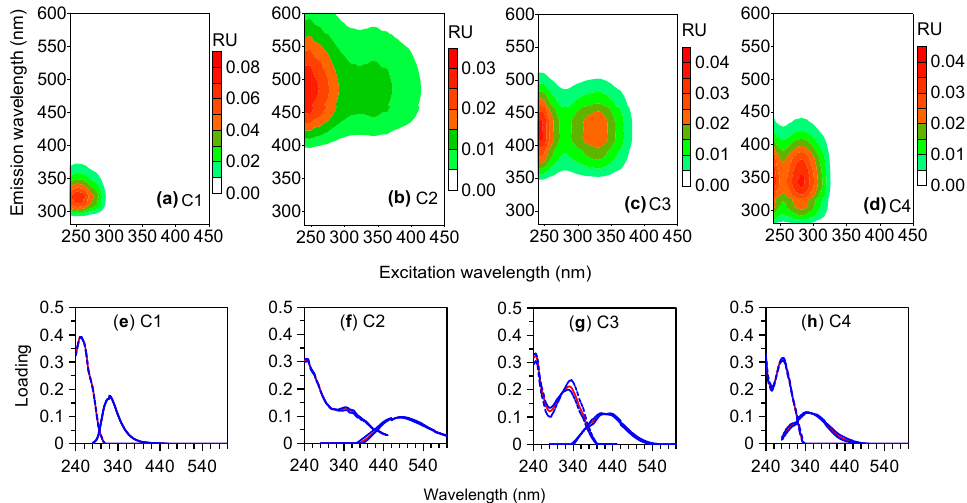
(0.30–0.39 RU) than for other sources (0.12–0.14 RU, Figure 3d). It decreased by 32%–53%